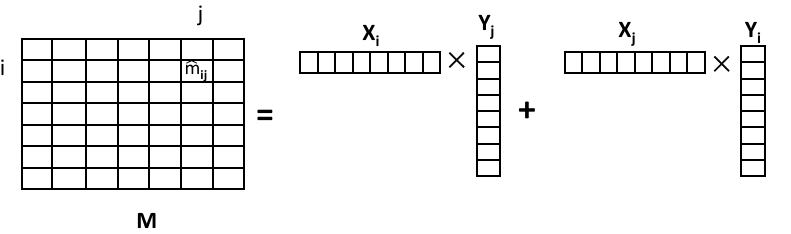
Figure 4. Vector representations for pedestrian flow matrix M